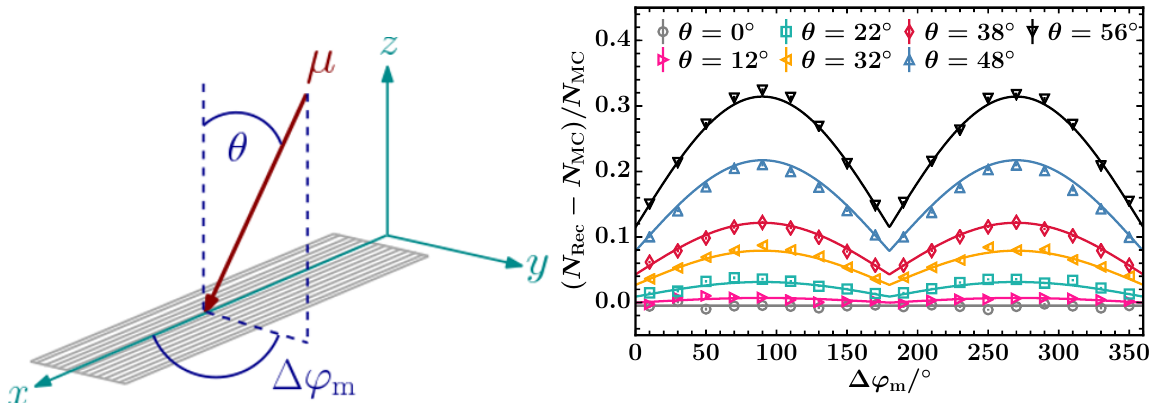
Figure 2: Left: Illustration of the dependence of over-counting due to corner-clipping muons on the direction of the impinging muon w.r.t. the orientation of the detector module. Right: Over-counting as a function of the azimuth di ff erence ∆ ϕ ff erent zenith angles θ . Markers show the weighted average percentage of over-counting, error bars the weighted m for di standard deviation in bins of 20 ◦ . The obtained parametrization of Eq. (2) is shown by solid curves for each zenith